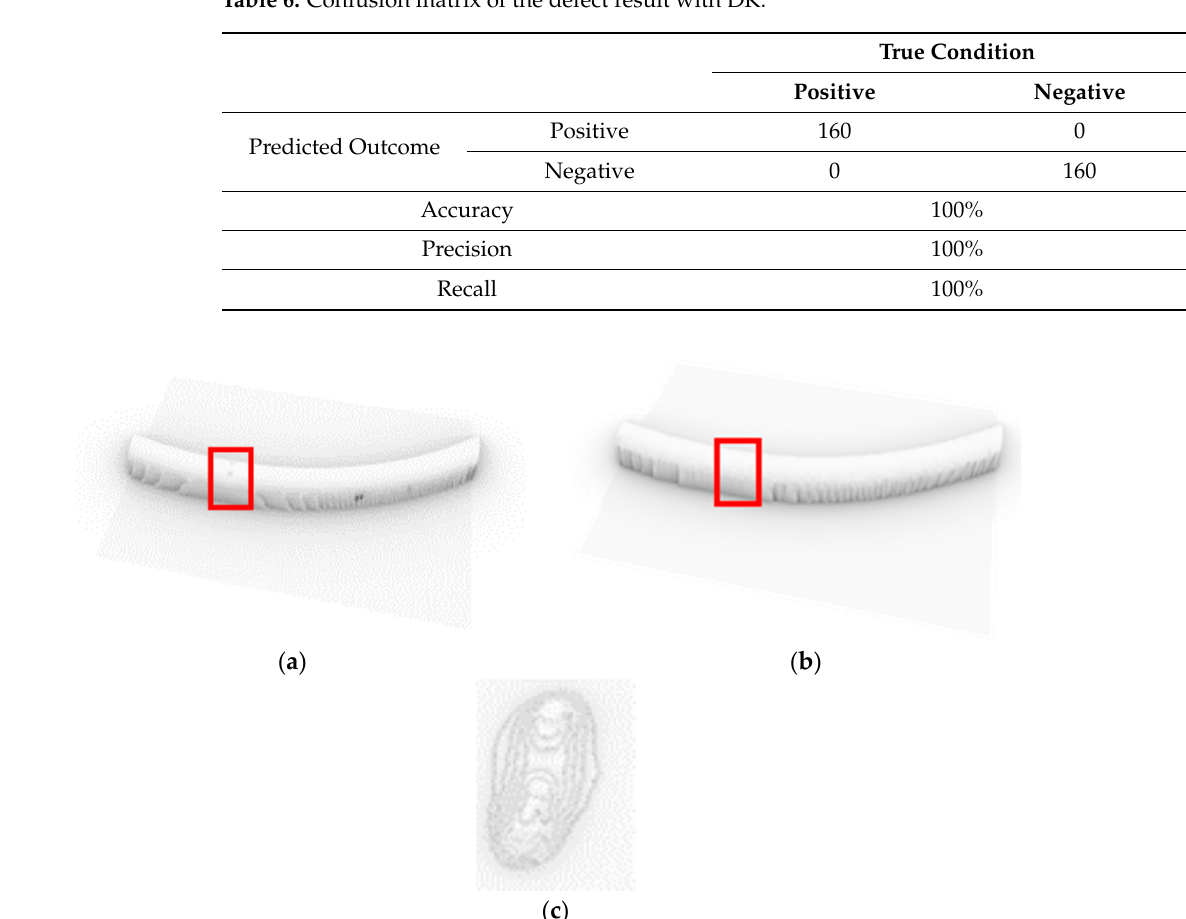
Figure 25. ( a ) optical profilometer model; ( b ) smooth model M S ; ( c ) subtracting result on defect candidate area.